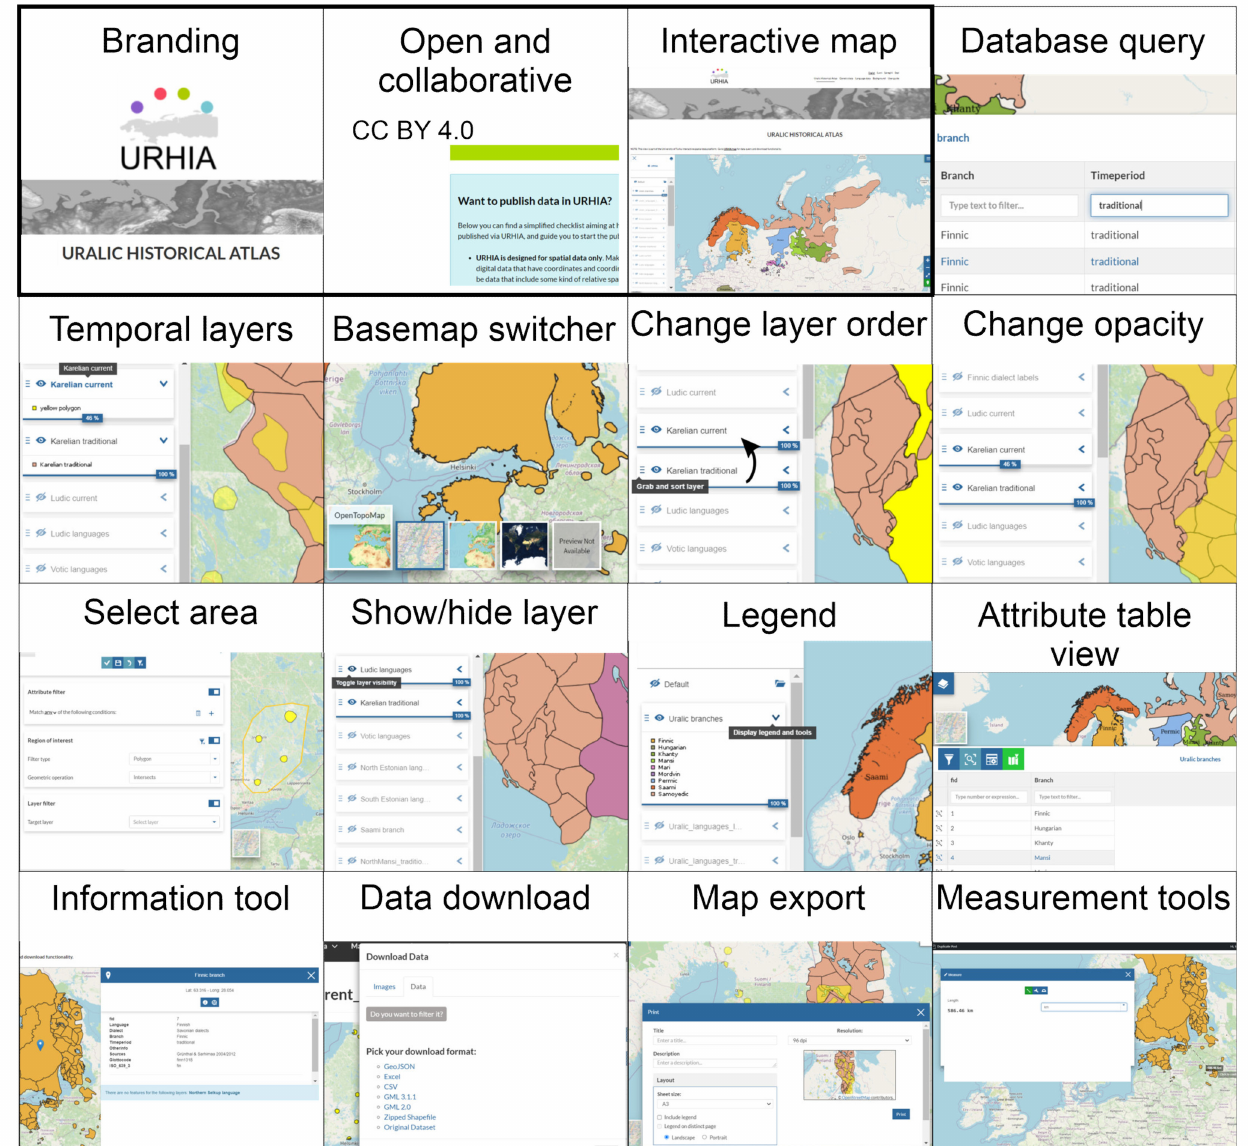
Figure 4. Visualizationof key functionalities implemented in the URHIA pilot spatial data platform (see Table